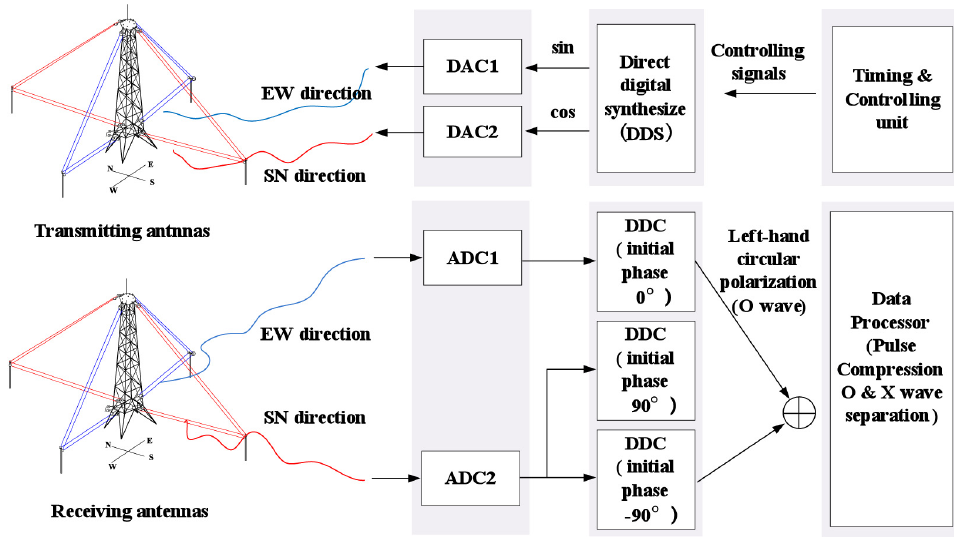
Figure 4. Block diagram for separating O wave in CAS-DIS.